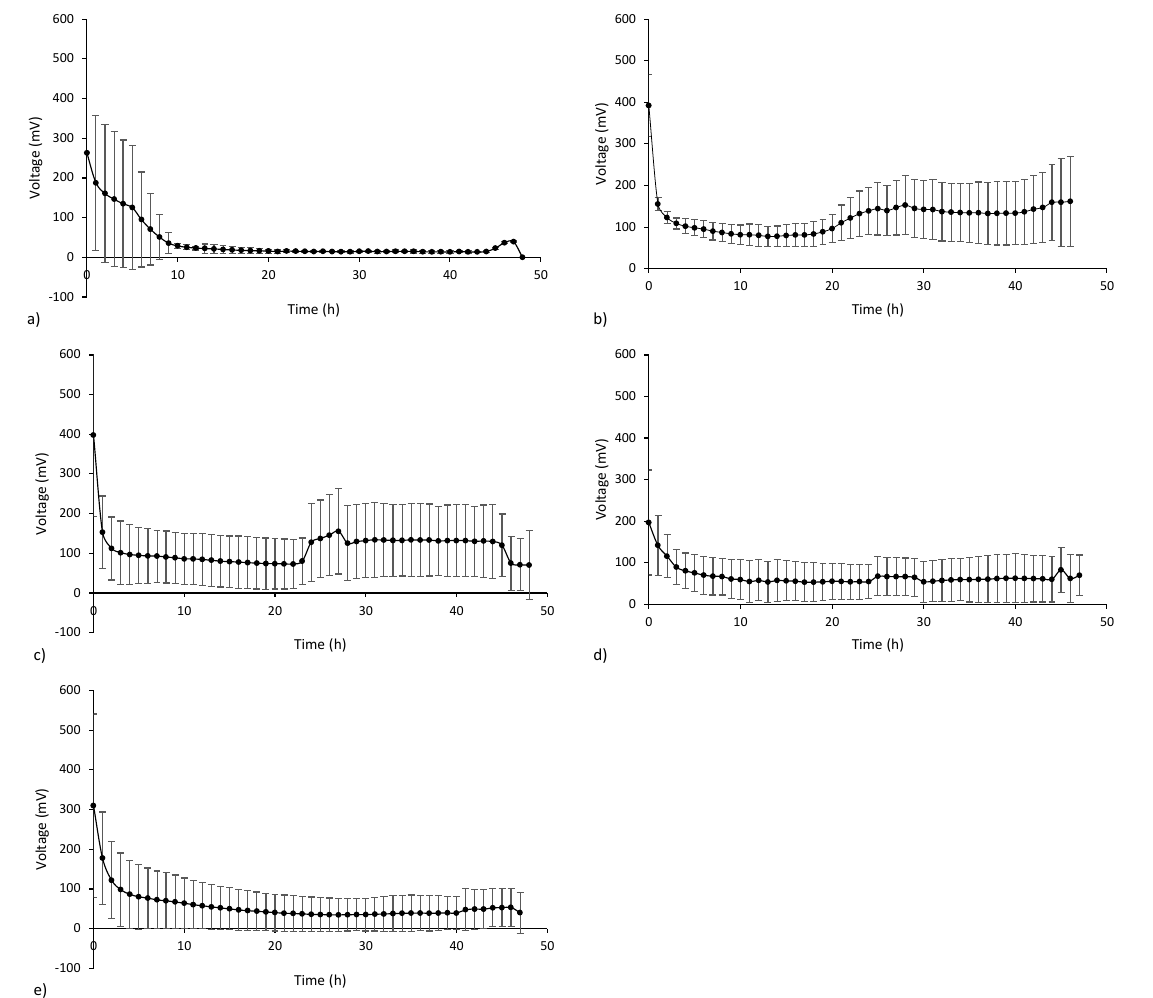
Figure 2. Averaged voltages ( n = 5) from the last 5 cycles for ( a ) MFC control , ( b ) MFC 0.05Fe, ( c ) MFC 0.1Fe , ( d ) MFC 0.2Fe , and ( e ) MFC 0.4Fe .